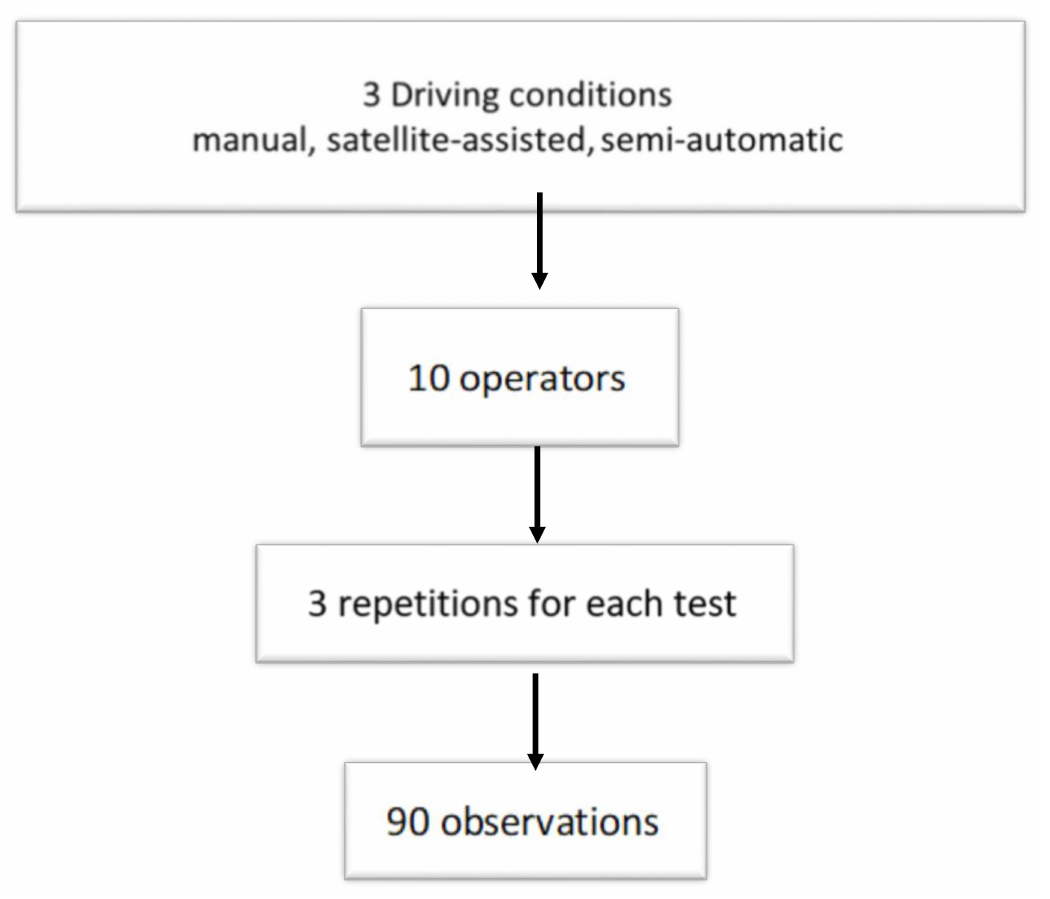
Figure 1. Experimental scheme of the